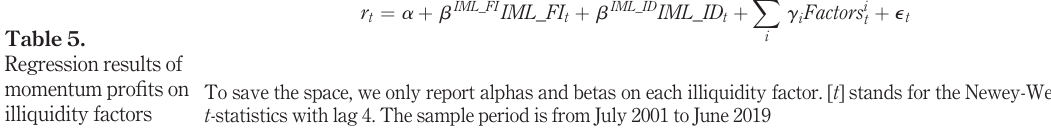
Table 5. Regression results of momentum pro fi ts on illiquidity